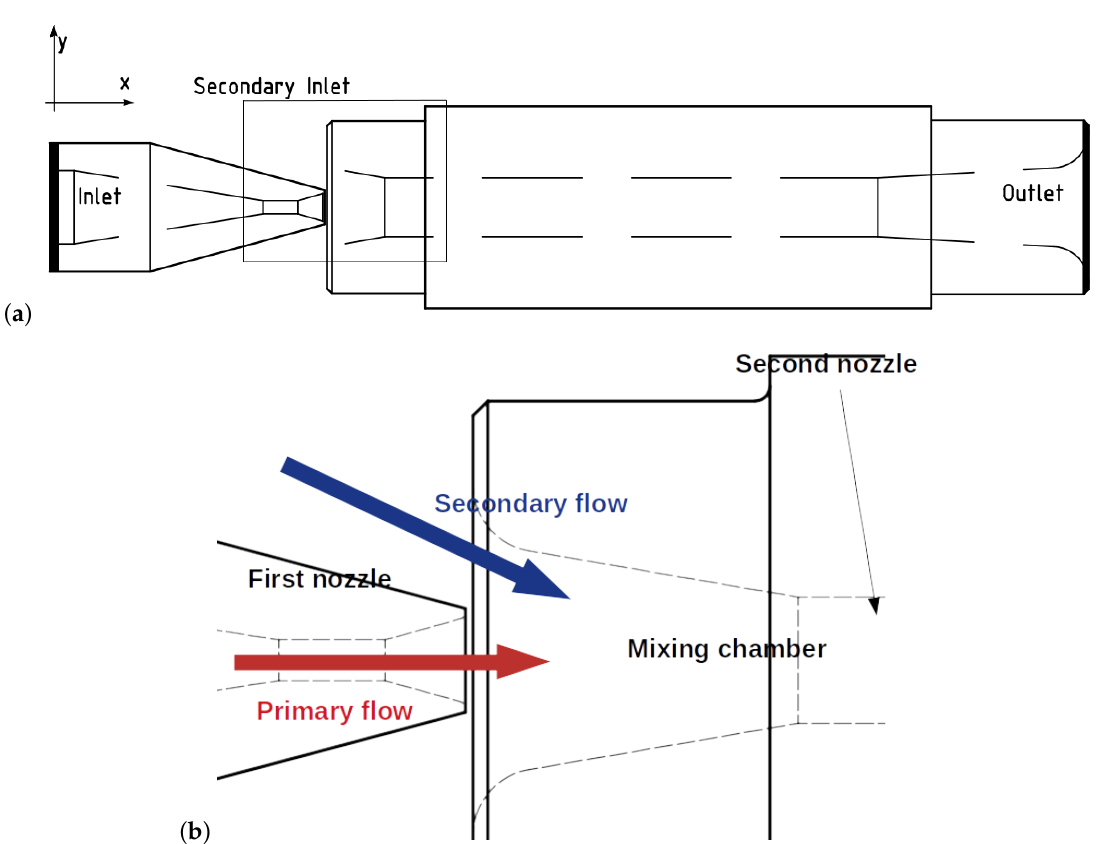
Figure 1. ( a ) Drawing of the vacuum ejector and its boundary names; ( b ) Detail with schematic representation of primary and secondary